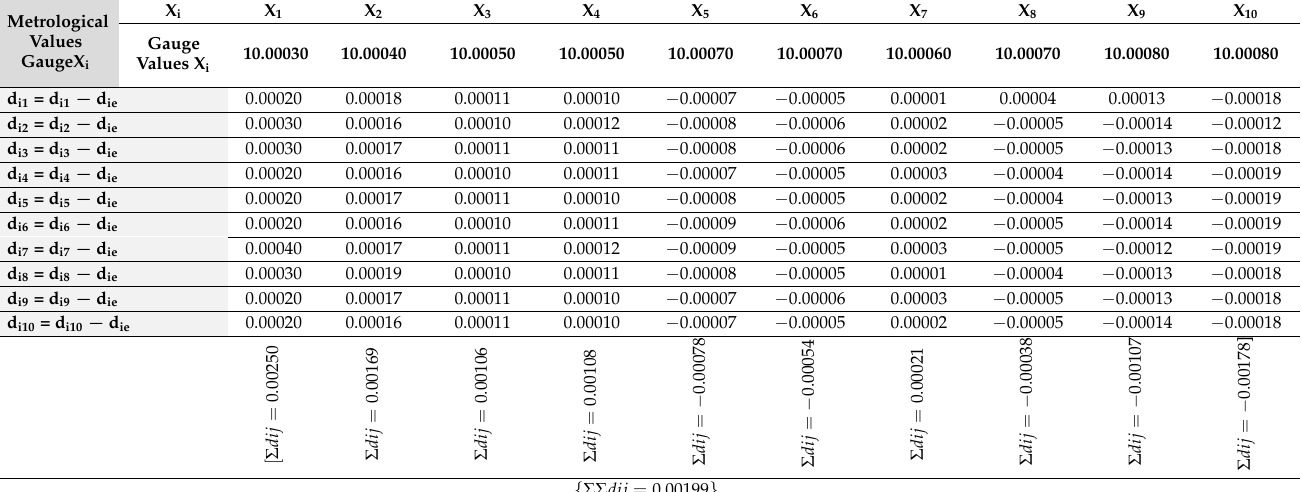
Table 4. Protocol of metrological measurements for determination of metrological values